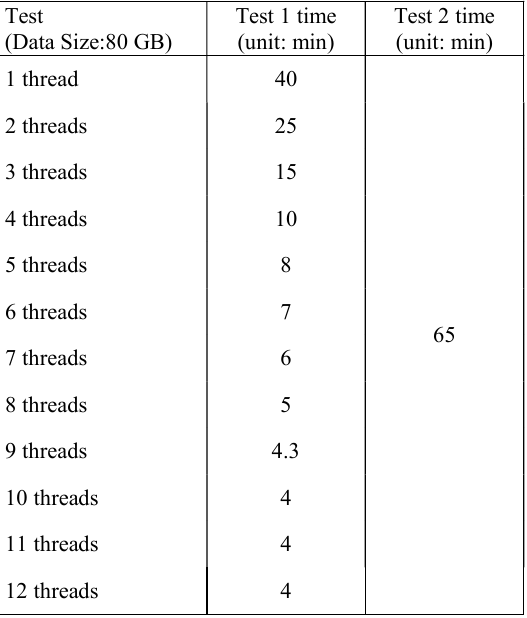
Table 1 . Performance test results.